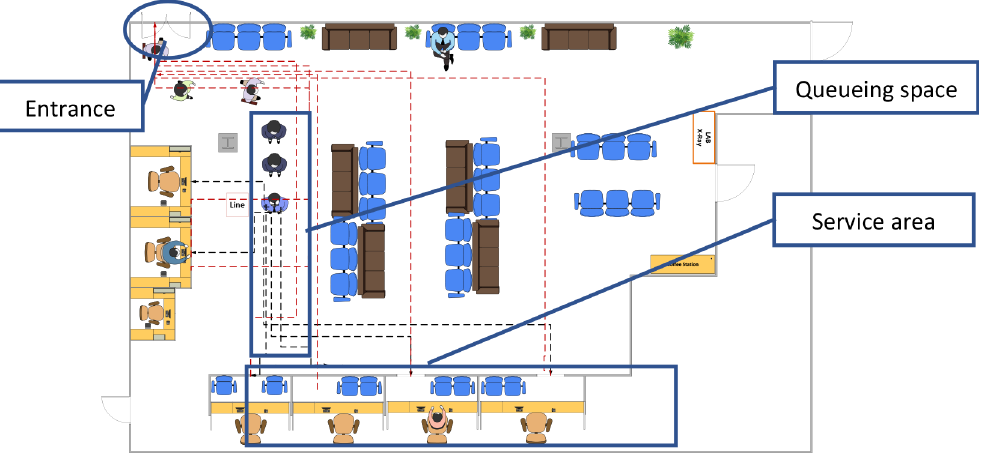
Figure 5. Central registration future design layout